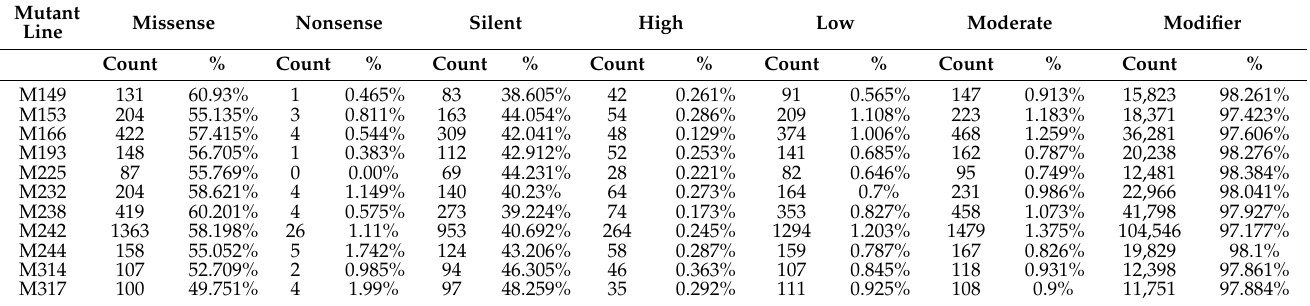
Table 6. Predicted effect of small